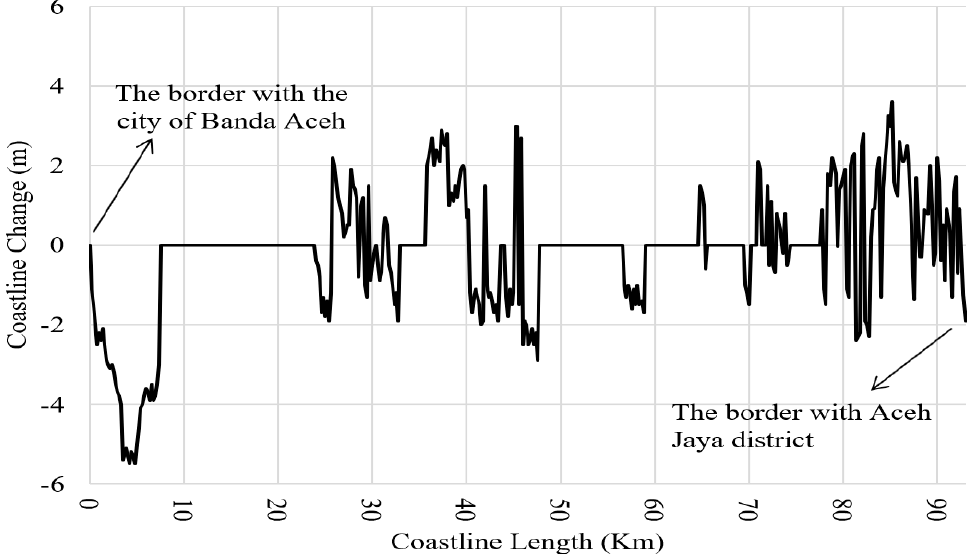
Figure 8. Graph of coastline changes along the west coast of Aceh Besar .